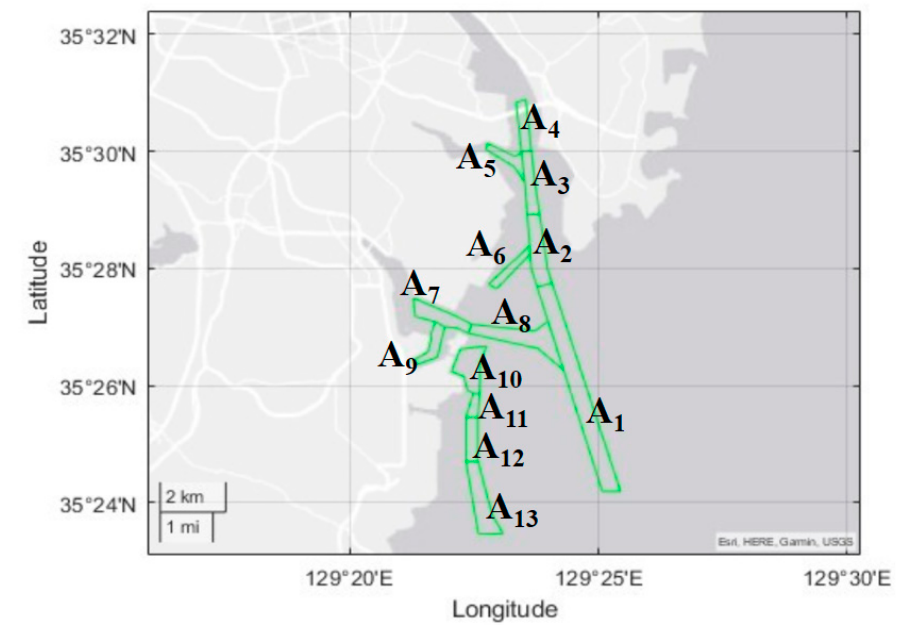
Figure 2. Definition of congestion area A k .